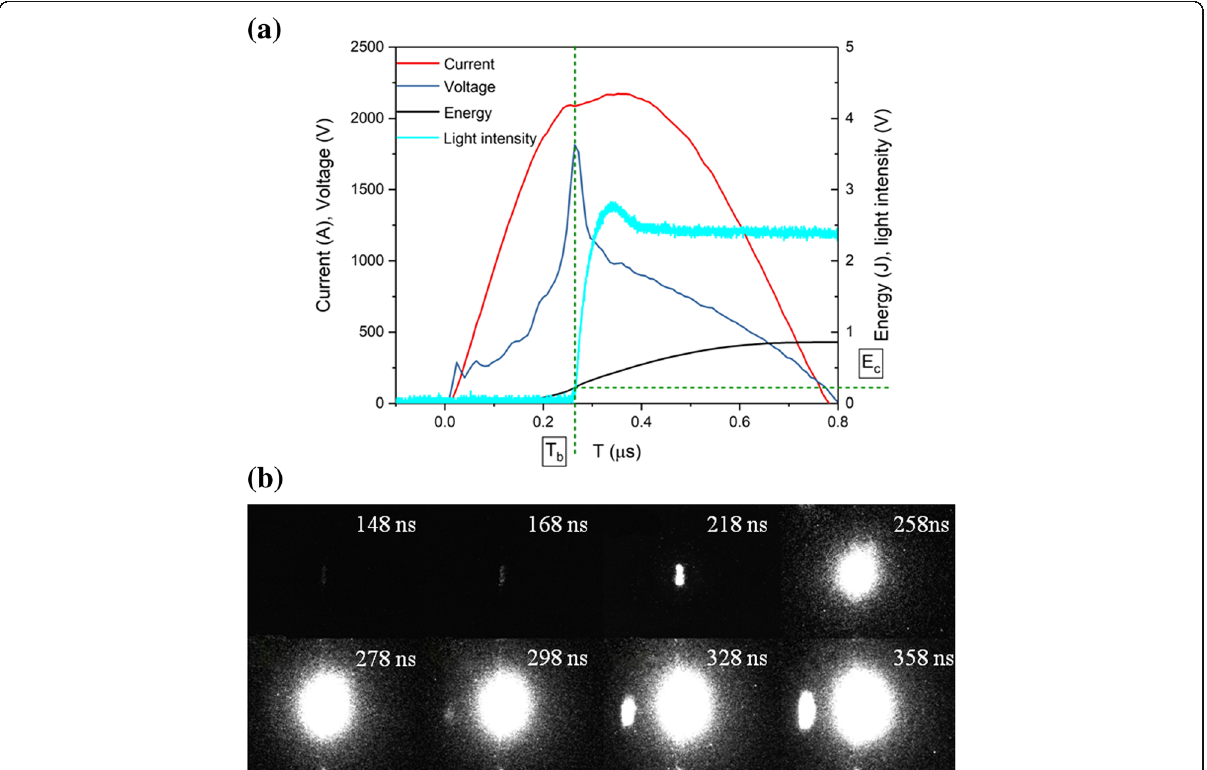
Fig. 4 a Evolution of the current-voltage and light emission intensity for energetic Al/Ni superlattice with the storage capacitor initially charged 3.5 kV. b Cross-sectional images of the dynamic processes by ultra-high-speed